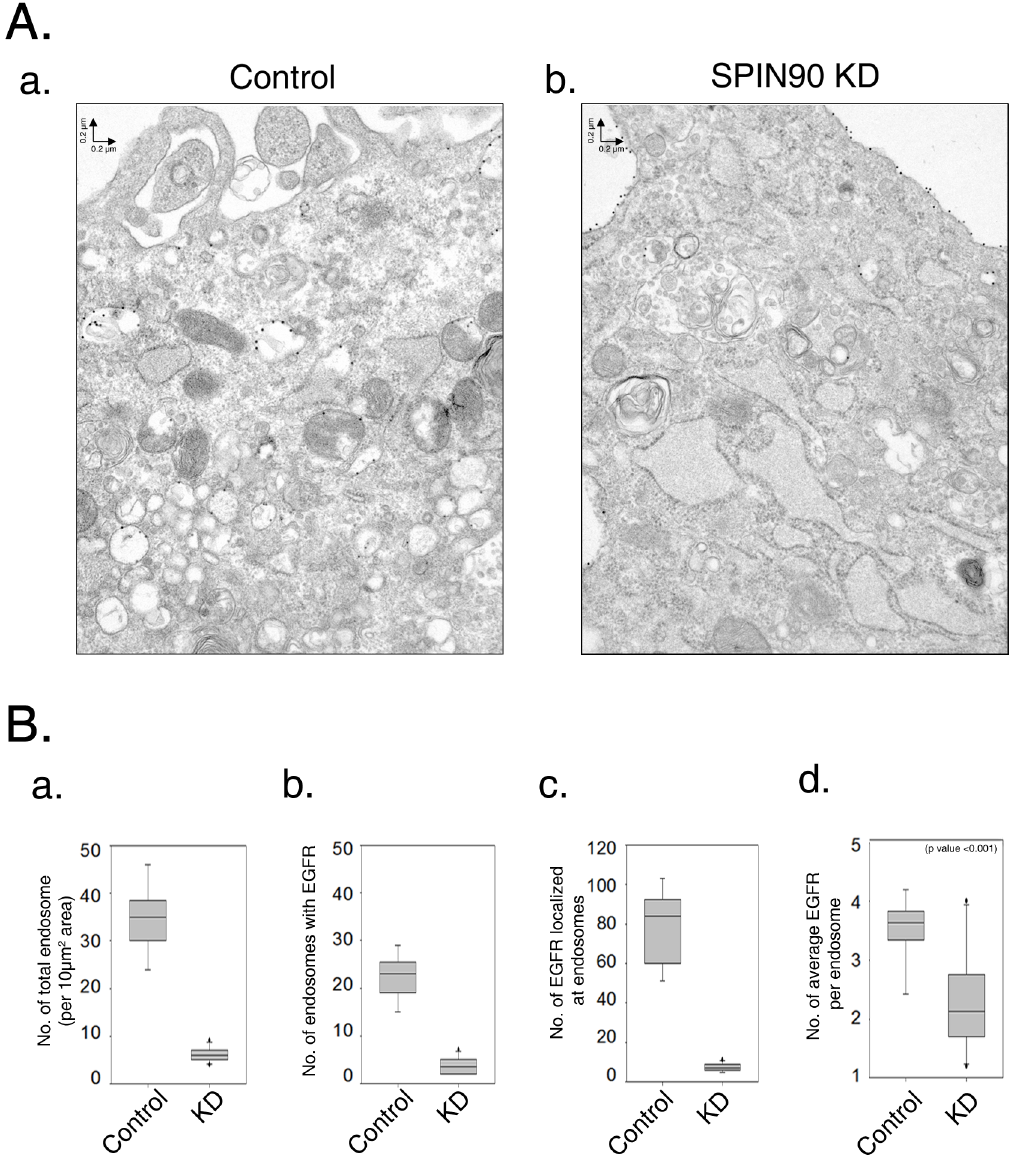
Figure 3. Immunogold staining of EGFR using electron microscopy. A. Control and SPIN90 knockdown (KD) HeLa cells were cultured for 24 h and suspended in serum-free medium for an additional 1 h. Cells treated with 40 ng/ml EGF were incubated for 10 min to allow EGFR internalization, and fixed with 4% paraformaldehyde. Cells were prepared for electron microscopy, as described in Material and Methods. Sectioned samples were stained with mouse anti-EGFR antibody and labeled with 25 nm gold particles conjugated to anti-mouse antibody. B . Numbers of total endosomes per image (4.8 m m 6 6.0 m m) (a), numbers of endosomes with EGFR (b), numbers of EGFR localized at endosomes (c) and average EGFR numbers per endosome (d) were